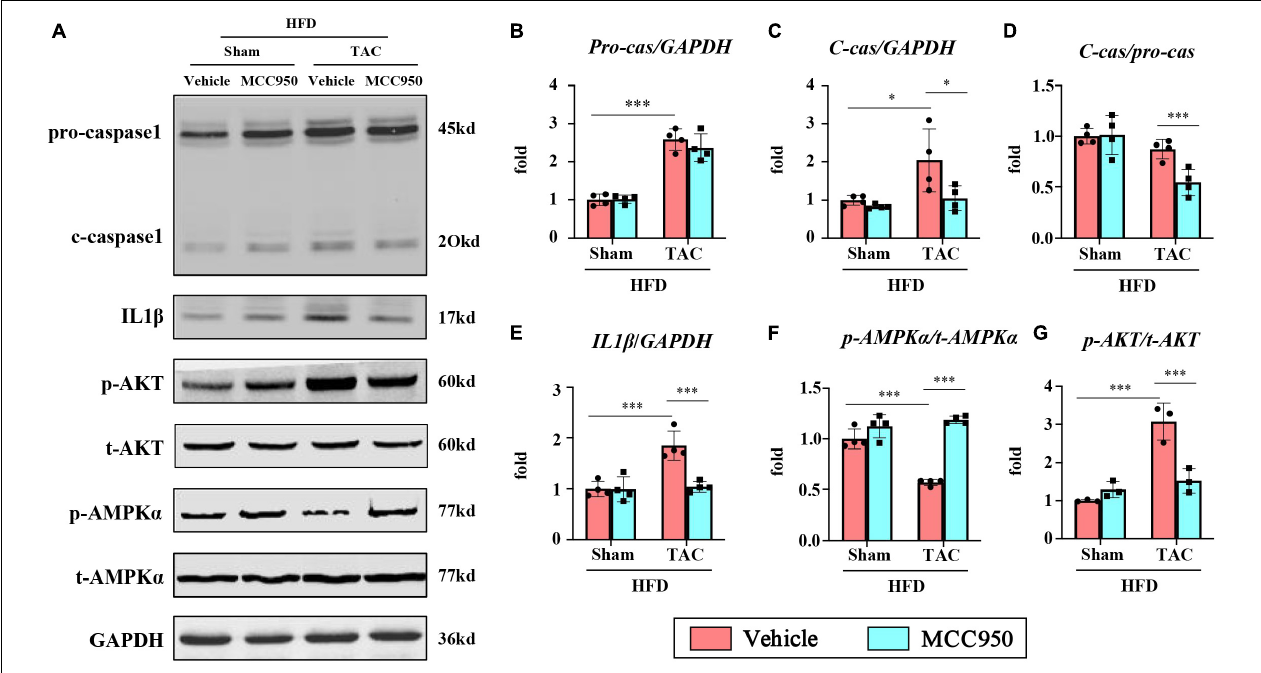
FIGURE 8 | MCC950 attenuated cardiometabolic disorder via AKT/AMPK pathway. (A) Representative Western blot and quantitative analysis showing the expression levels of (B) pro-caspase-1, (C) c-caspase-1, (D) the ratio of c-caspase-1/pro-caspase-1, (E) IL-1 β , (F) p-AMPK α , and (G) p-AKT in different groups, n = 4. IL, interleukin; AKT, phospho-protein kinase B; AMPK α , AMP-activated protein kinase α . * p < 0.05, ** p < 0.01, *** p < 0.001.